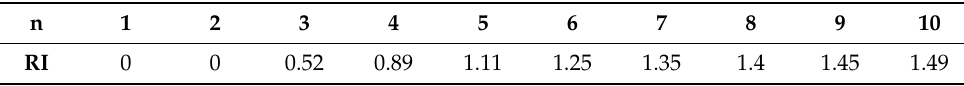
Table 2. The average values of the Random